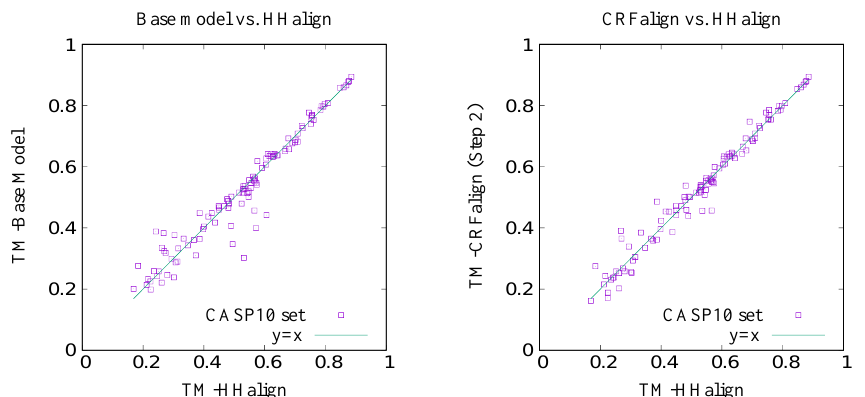
Figure 9. Comparison of TM scores for CASP10 targets by Modeller modeling based on ( left ) base alignment (average TM score = 0.5246) vs. HHalign alignment (average TM score = 0.5286) and ( right ) CRFalign alignment (average TM score = 0.5321) vs.